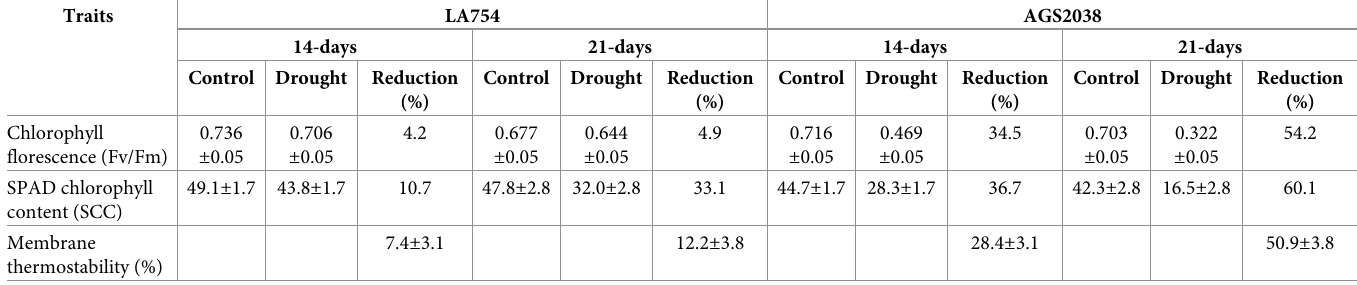
Table 1. Mean ( ± SE) of chlorophyll florescence (Fv/Fm ratio), SPAD chlorophyll content and membrane thermostability, and percent (%) reduction due to stress in two wheat genotypes under control and drought conditions at 14 and 21 days after water stress imposition. Traits